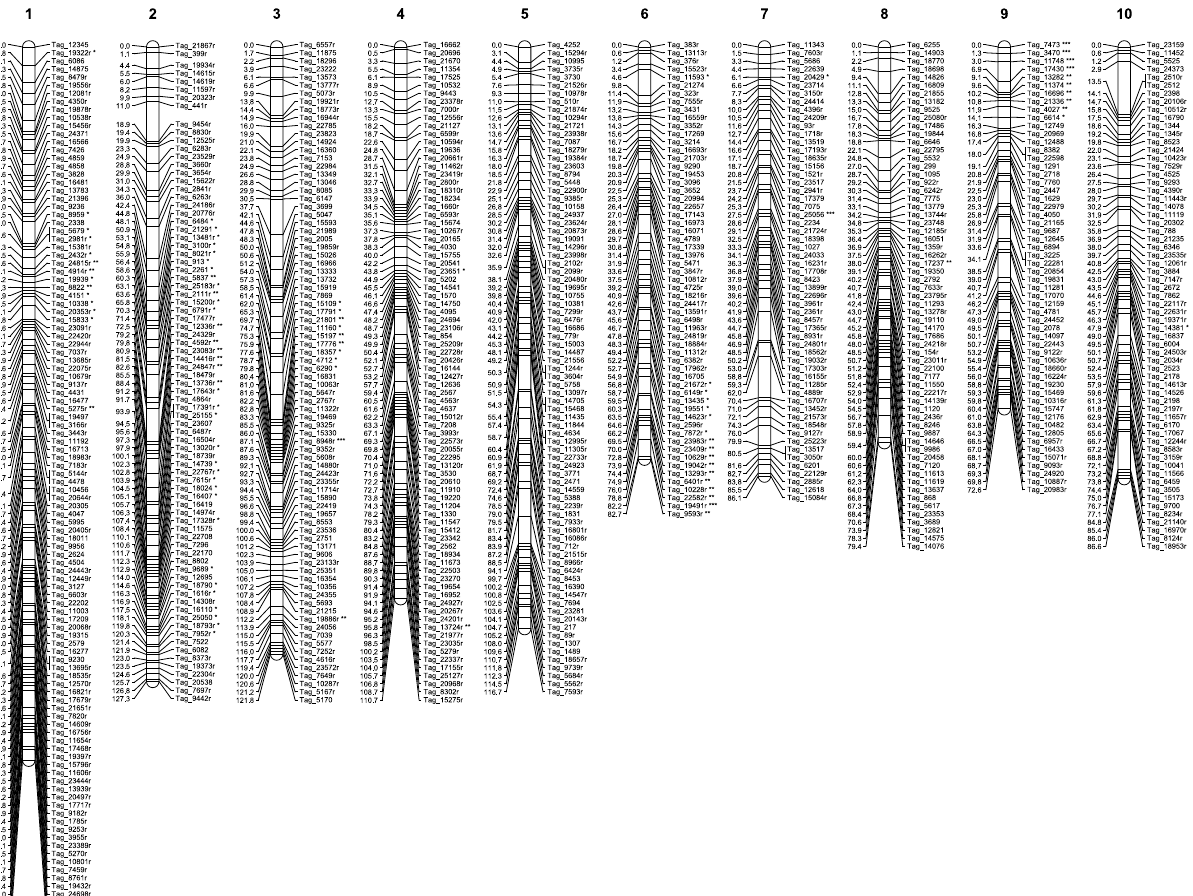
Figure 2. Paternal genetic map comprised of markers that were homozygous in 509022 and heterozygous in HI33. SNP markers were identified using a fragmented seashore paspalum genome sequence as reference. Only one marker per set of cosegregating markers is shown. Markers that deviated significantly from the Mendelian segregation ratio of 1:1 are indicated with * (deviation at the 5% level), ** (1% level) or *** (0.1% level) next to the marker